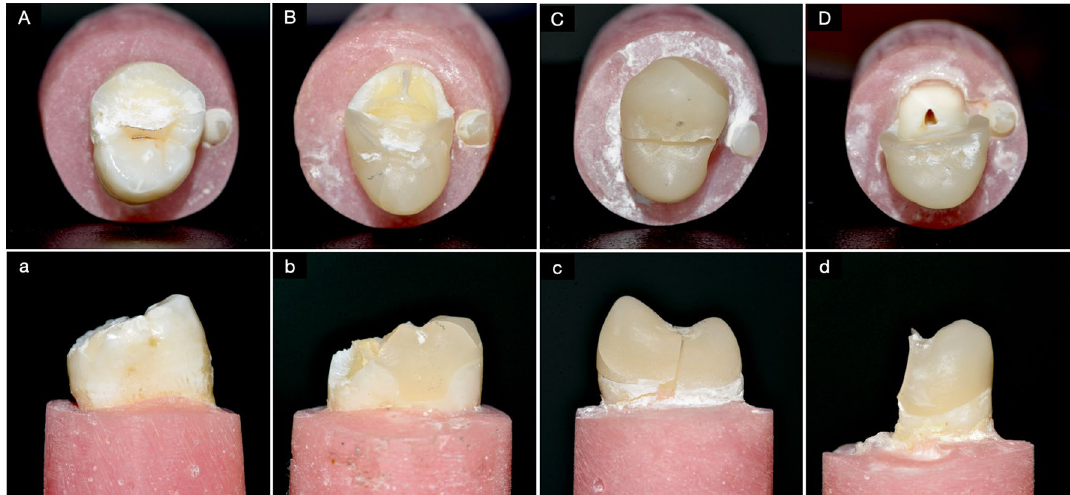
Figure 6. The characteristics of the observed fractures are shown in occlusal view (uppercase letters) and proximal view (lowercase letters). In the control group, the fracture was always within the dentin ( A ) and it was always above the CEJ ( a ). In the overlay-restored groups, four of the forty-two specimens involved only the restoration and dentin ( B ) and three of these unusual specimens were above the CEJ ( b ). All of the other overlay-restored specimens fractures involved pulp tissue ( C and D ) below the CEJ ( c and d ). Roughly half of those specimens fractured across the middle of the tooth ( C and c ), and in the others a large portion of the tooth fell off ( D and d